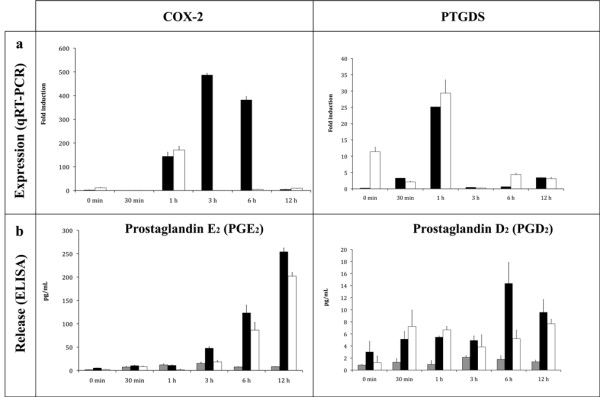
Temporal characterisation of the prostaglandin response. Time course response to macrophages stimulated during 0, 30 min, 1, 3, 6, and 12 h with 10 μg/mL of PGN O111:B4 and K12. Experiments were performed in independent groups of PGN-stimulated (n = 3) or control macrophage cultures (n = 9). a) COX-2 and PTGDS mRNA abundance over time in response to PGN-B4 (black bar) or PGN-K12 (white bar). Were observed significative differences in the mRNA abundance between the times and treatments (PGNs) in both genes (two way ANOVA p < 0.01). b) PGE2 and PGD2 release (pg/mL) stimulated by PGN-O111:B4 (black bars), PGN-K12 (white bars) and control (grey bars) into the culture medium (n = 3/treatment). Were observed significative differences in the release between the times and treatments (PGNs or control) by both prostaglandin (two way ANOVAs p < 0,01). The results are presents as fold change relative to 18S abundance and ± std deviation.